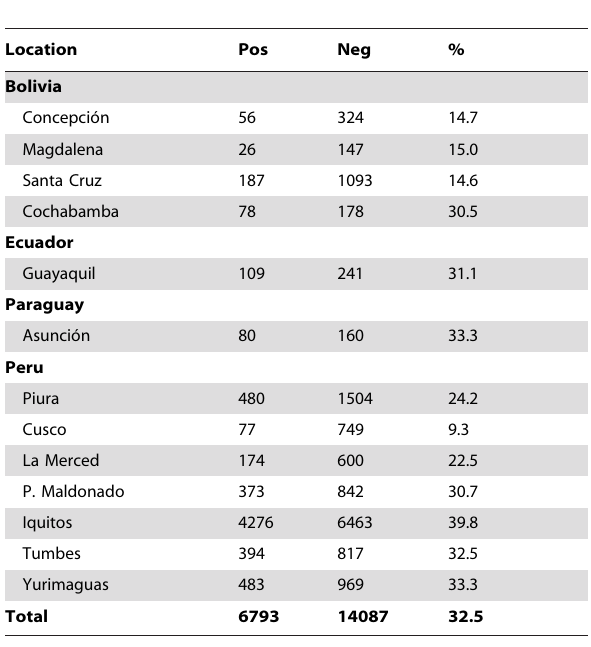
Table 3. Percentage of febrile participants with evidence of recent infection by one or more arboviruses, by location,